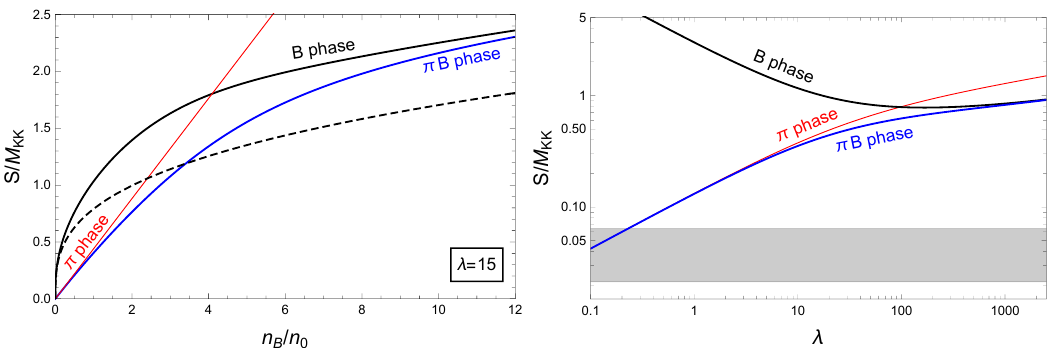
Figure 6: Left panel: Symmetry energy S in units of M ber density n in units of the saturation density n B λ = 15 in the different phases. The unlabeled (black) dashed curve is the low-density ap- proximation (65). Right panel: Symmetry energy at the ( λ -dependent) saturation density n as a function of the ’t Hooft coupling λ . The shaded band indicates the physical value 0 S (cid:39) 32MeV for the range of the Kaluza-Klein scale M